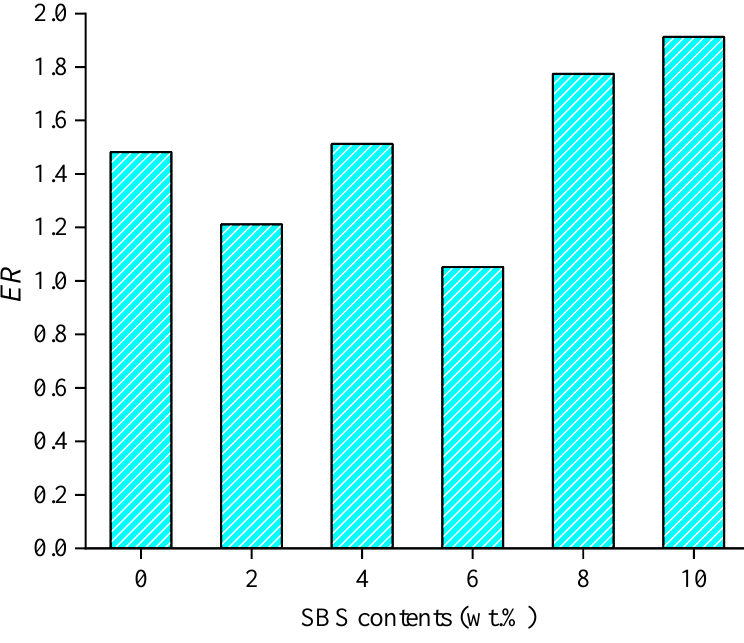
Figure 9. Variation in ER values with SBS content.